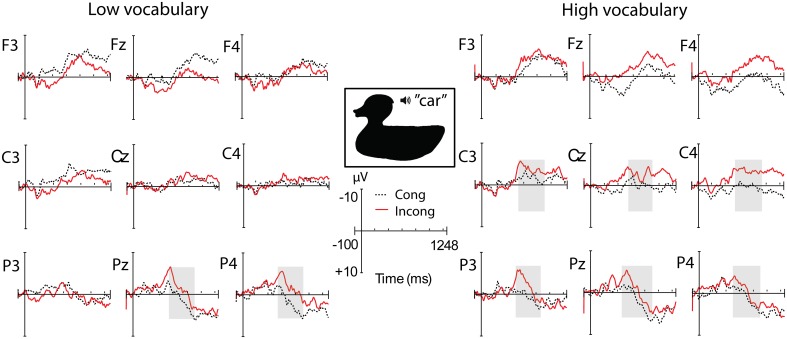
ERP topography for the congruous and incongruous silhouette conditions at 24 months, displayed for the two vocabulary groups separately. Time windows with significant effects in separate group analyses are shaded in gray.